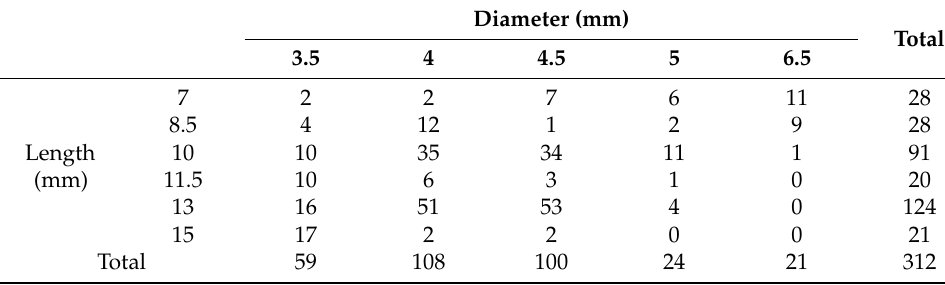
Table 1. Frequency of implant length and implant diameter.